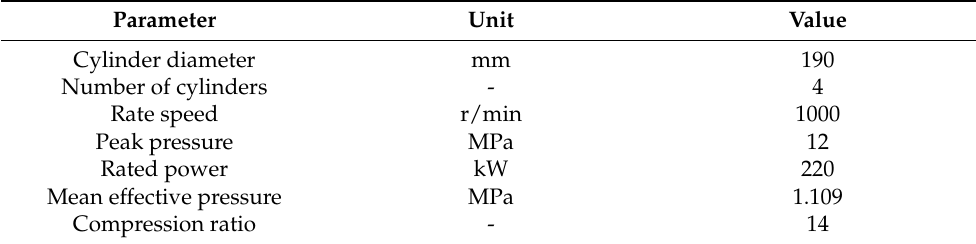
Figure 1. Simulation model of an entire diesel engine. Table 1. Main parameters of a diesel